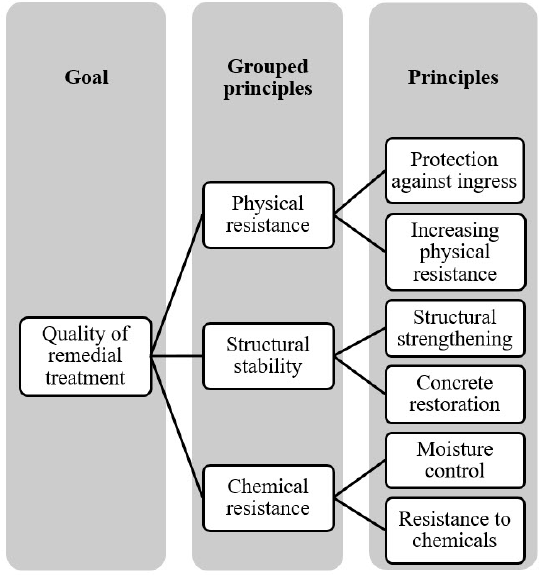
Figure 4. Classification of repairing principles.